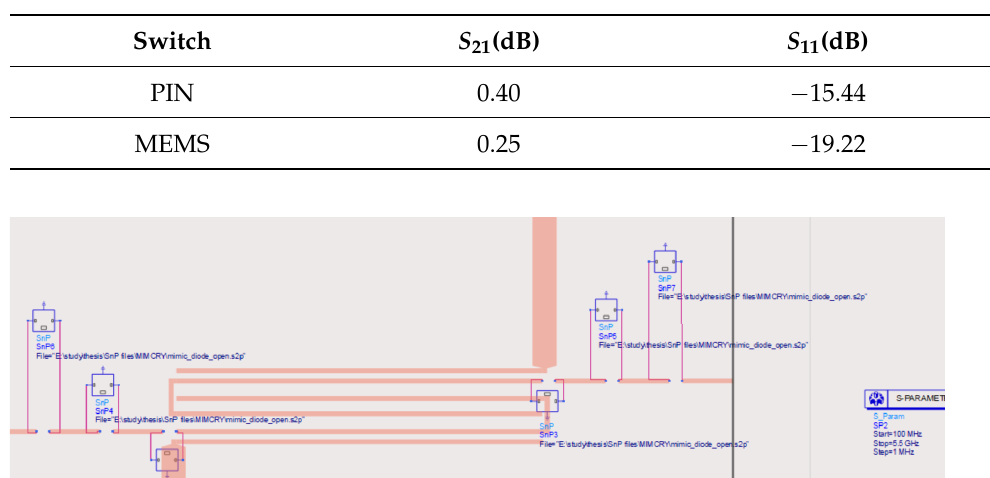
Figure 11. RF-MEMS’ measured scattering parameters: ( a ) OPEN, ( b ) CLOSE states. Table 3. Comparison of scattering parameters between PIN diode and RF-MEMS switches in CLOSE configuration.